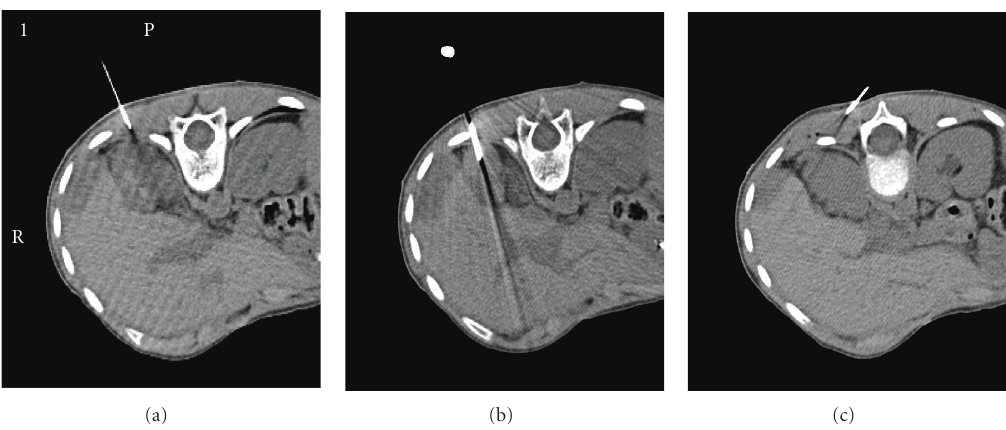
Figure 5: Radio frequency ablation and cryoablation procedure . Under direct CT fluoroscopic guidance, an RFA electrode was advanced into the perihepatic lesions. These were heated from 42 ◦ C to 43 ◦ C for 30 minutes (a) and (b) then a cryoablation probe was advanced and 2 cycles of freeze and thaw for 8–10 minutes